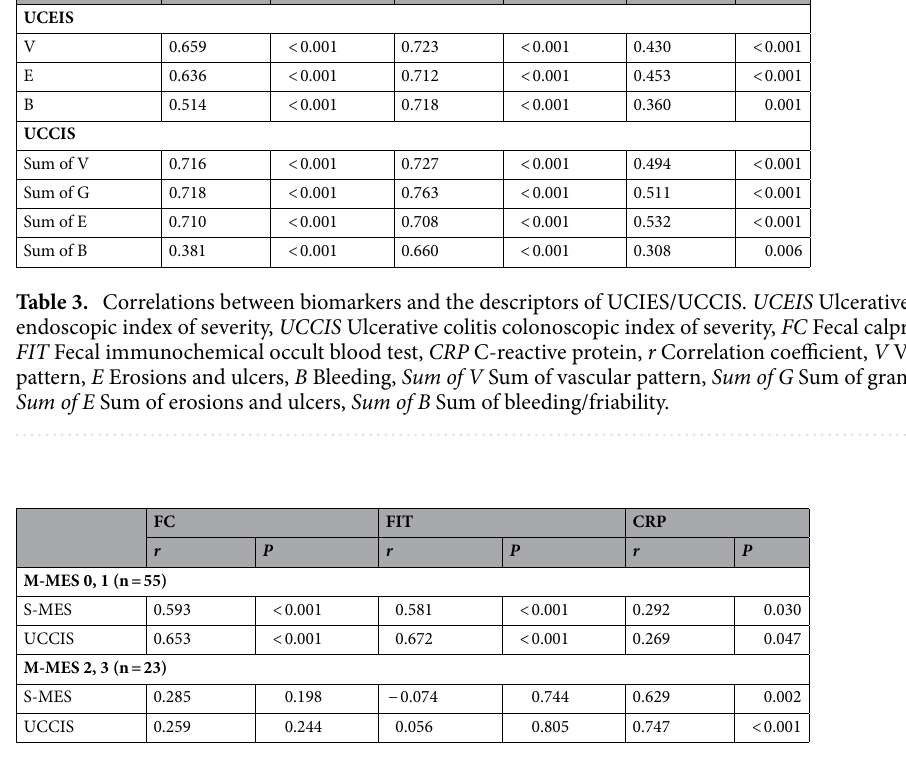
Table 4. Correlations between biomarkers and endoscopic scores divided into two groups—M-MES 0, 1 and M-MES 2, 3. M-MES Maximum Mayo endoscopic subscore, FC Fecal calprotectin, FIT Fecal immunochemical occult blood test, CRP C-reactive protein, r Correlation coefficient, S-MES Sum of Mayo endoscopic subscore, UCCIS Ulcerative colitis colonoscopic index of